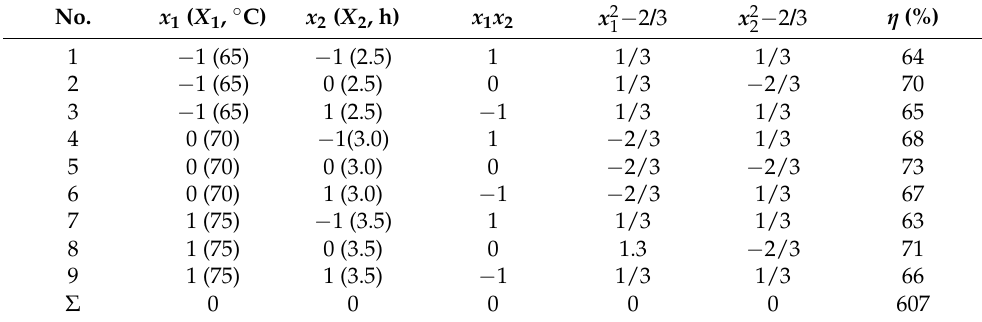
Table 1. Experiment 3 2 for molecule VIII.